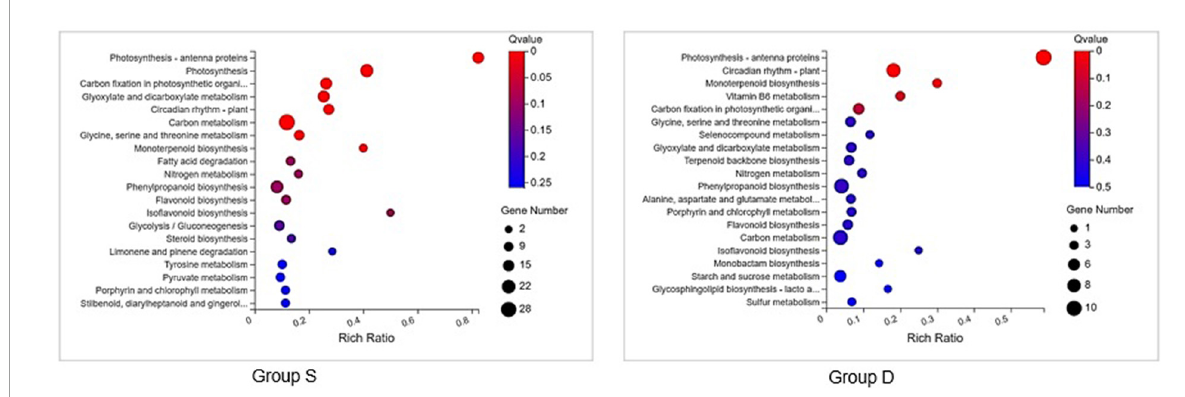
FIGURE4 KEGG pathway enrichment scatters plot of experimental groups at 12hpi. Top 20 enriched pathways of KEGG metabolism pathway categories of DEGs in groups S (left) and D (right). The vertical axis represents the pathname, and the horizontal axis represents the path factor corresponding to the Rich factor. The color of the point represents the size of the q -value. The number of differential genes included in each pathway is expressed by the point’s size. (The smaller the Q -value, the closer the color is to the red